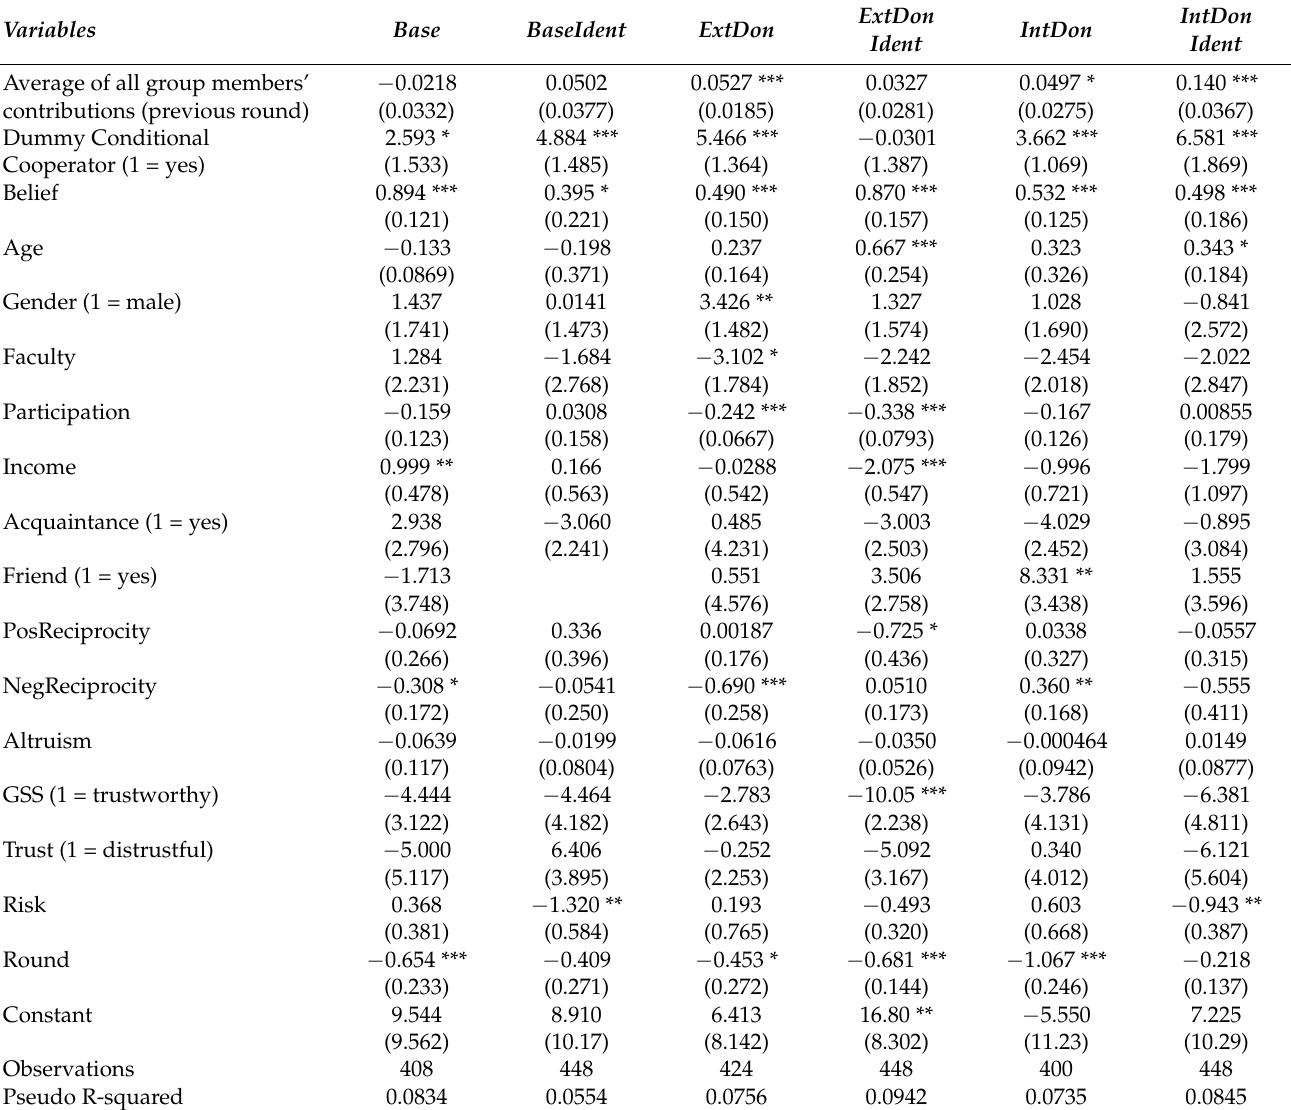
Table A8. Tobit regression on individual contribution by treatment showing